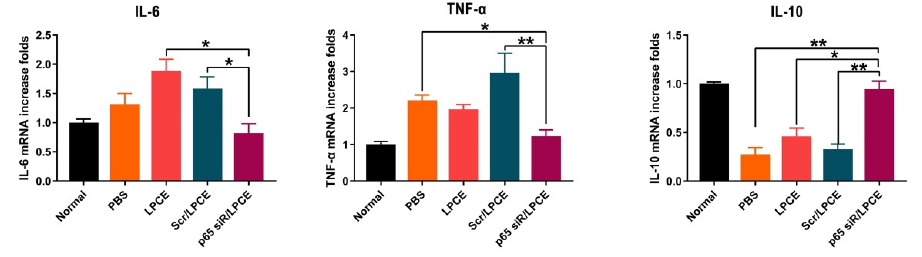
Figure 6. The p65 siRNA/LPCE complex regulates the secretion of inflammatory factors in vivo. The expression of anti-inflammatory cytokine IL-10 was significantly increased, and pro-inflammatory cytokine NF- κ B p65, TNF- α , IFN- γ , IL-1 β , and IL-6 were decreased. (** p < 0.01, * p < 0.05).